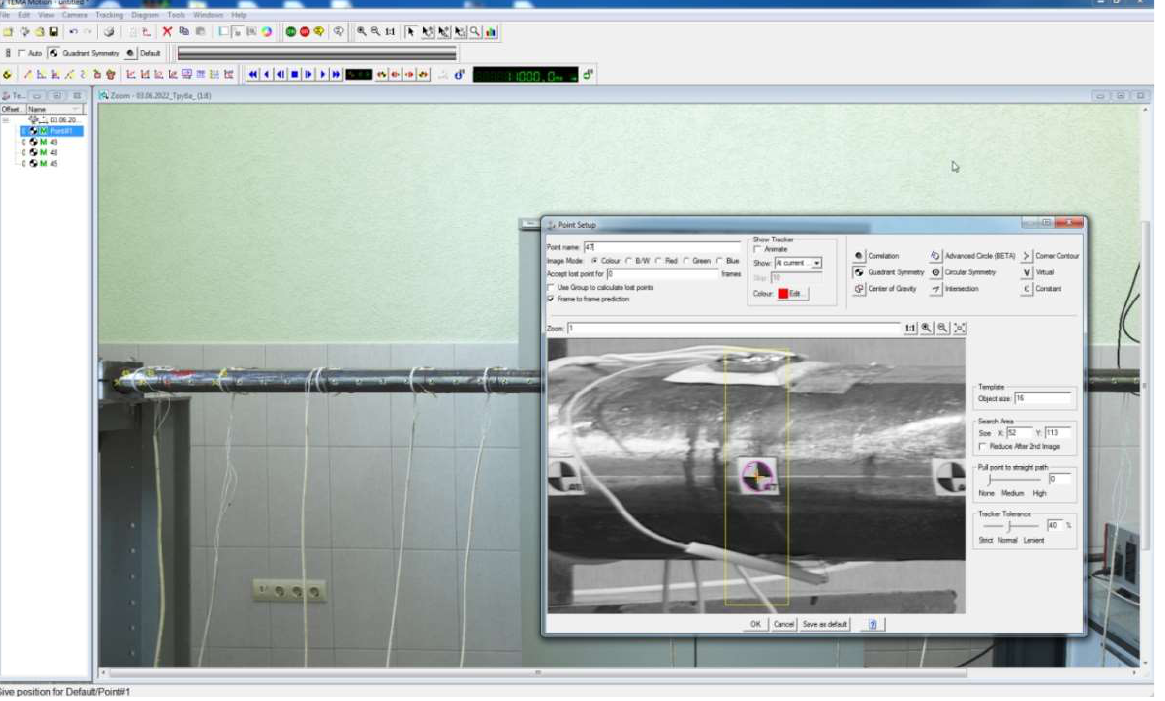
Figure 17. The ThemeMotion software interface.